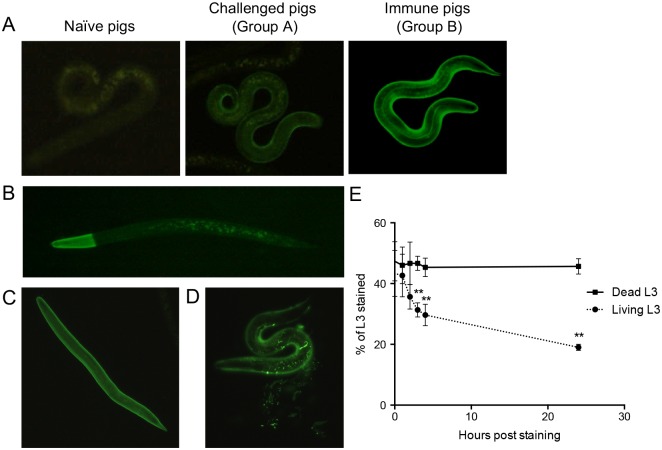
Mucosal antibodies from immune pigs recognize antigens on the surface of A. suum L3 that likely contain phosphorylcholine groups and are actively secreted by living larvae.(A) UV-microscopy images (400x) of A. suum L3 larvae stained by mucosal antibodies from naïve pigs, challenge control pigs (Group A) or immunized pigs (Group B) and incubated with FITC labeled anti-pig IgG. (B) UV-microscopy image (400x) of A. suum L3 larva partially stained by mucosal antibodies from immune pigs and incubated with FITC labeled anti-pig IgG. (C) A UV-microscopy image (400x) of an A. suum L3 larva stained by anti-PC antibodies and (D) a stained larva in the process of shedding these antigen-antibody complexes. (E) The percentage of A. suum L3 stained by mucosal antibodies from immune pigs decreased over time when L3 were kept alive in culture media (dotted line) but not when L3 were killed after staining (full line) (P < 0.01).